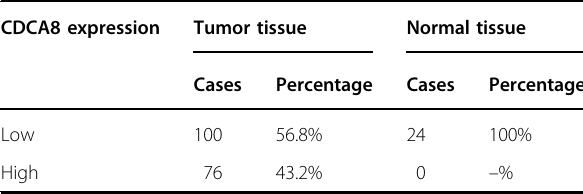
Table 1 Expression patterns of CDCA8 in glioma tissues and normal tissues revealed in immunohistochemistry